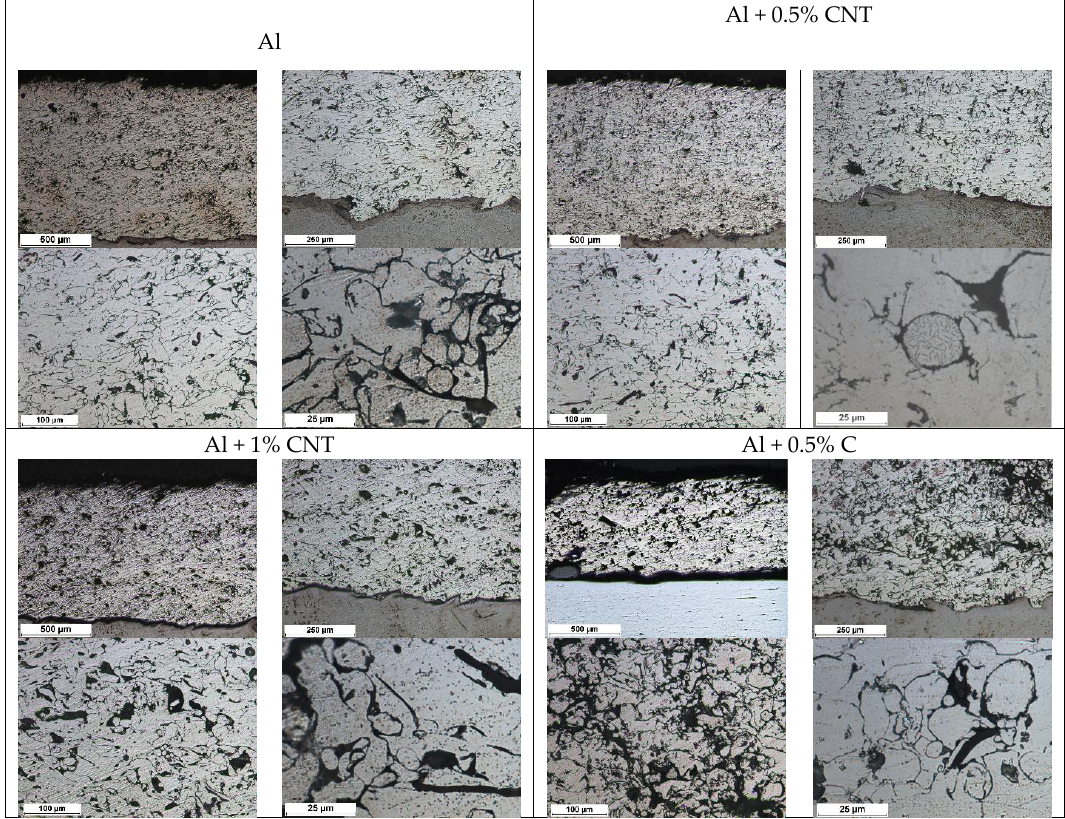
Figure 5. The macro and microstructure of the flame-sprayed pure aluminum and aluminum matrix with carbon nanotubes and carburite reinforcement coatings; etching: HCl + HNO 3 .